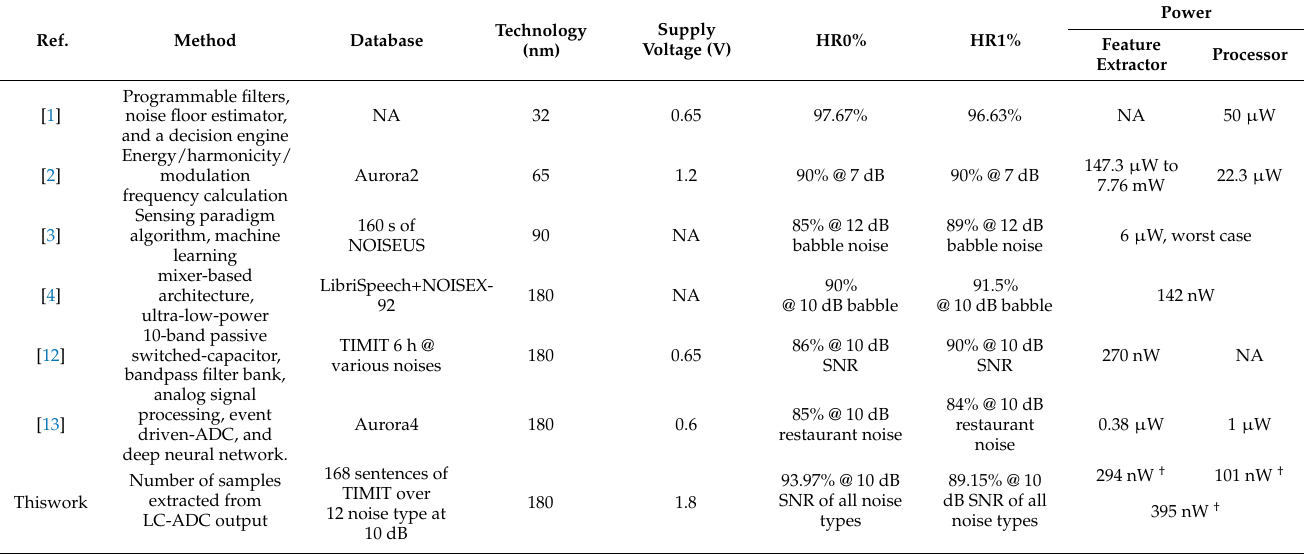
Table 3. Performance comparison with other VAD